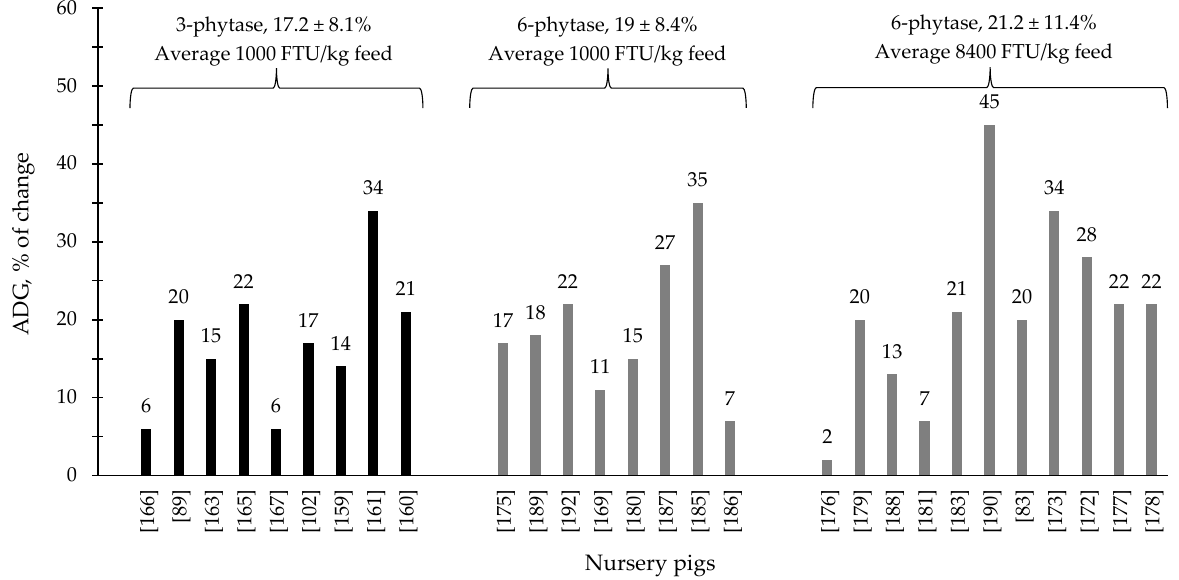
Figure 2. Changes in the average daily gain (ADG) of nursery pigs by 3- and 6-phytase supplemen- tation among the studies displayed in Table 2 that showed changes in the ADG. The studies were selected from peer-reviewed literature available after 2000. The percentage of change refers to a statistically significant ( p < 0.05) and tendency (0.05 ≤ p < 0.10) effects of phytase individually on the ADG reported from each respective study. The described effects were in comparison with treat- ments containing no phytase. The average changes in the ADG of nursery pigs by 3- and 6-phytase supplementation were calculated excluding the studies that showed no effect.